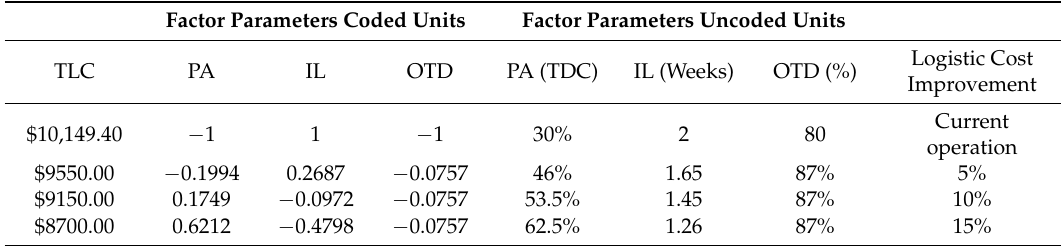
Table 4. Logistic Cost Optimization Parameters